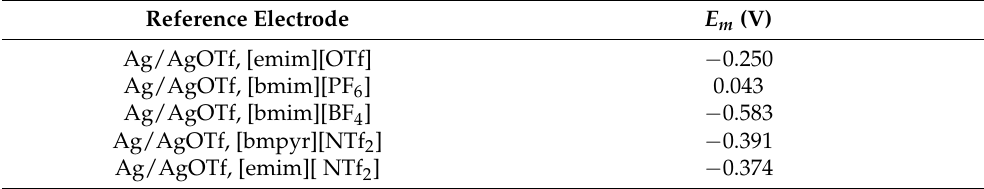
Table 2. Mid-point potential of Fc 0/+ against different Ag/AgOTf, R reference electrode. Reference